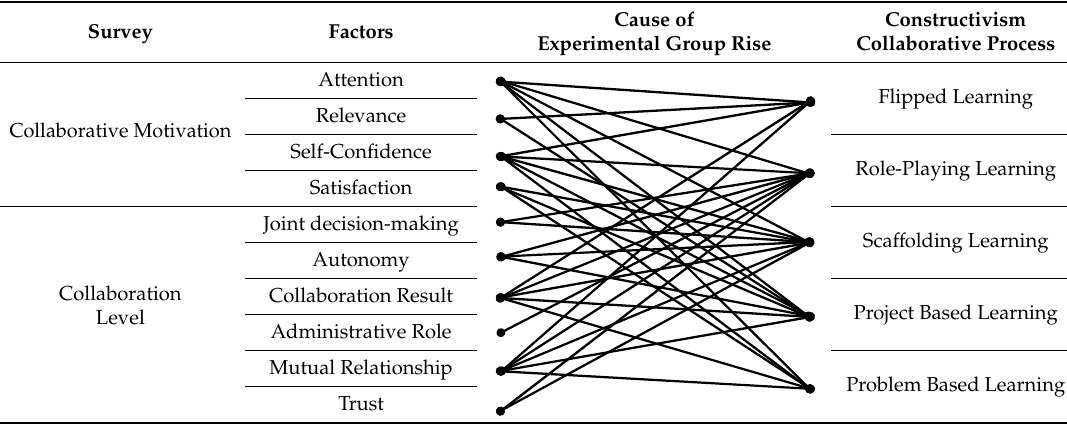
Table 16. An analysis of e ff ective constructivism training methods for collaboration. Survey